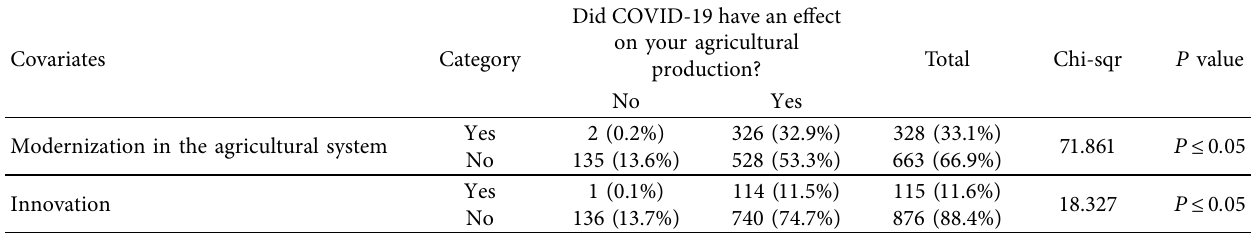
Table 5: Opportunities of COVID-19 in agricultural production.